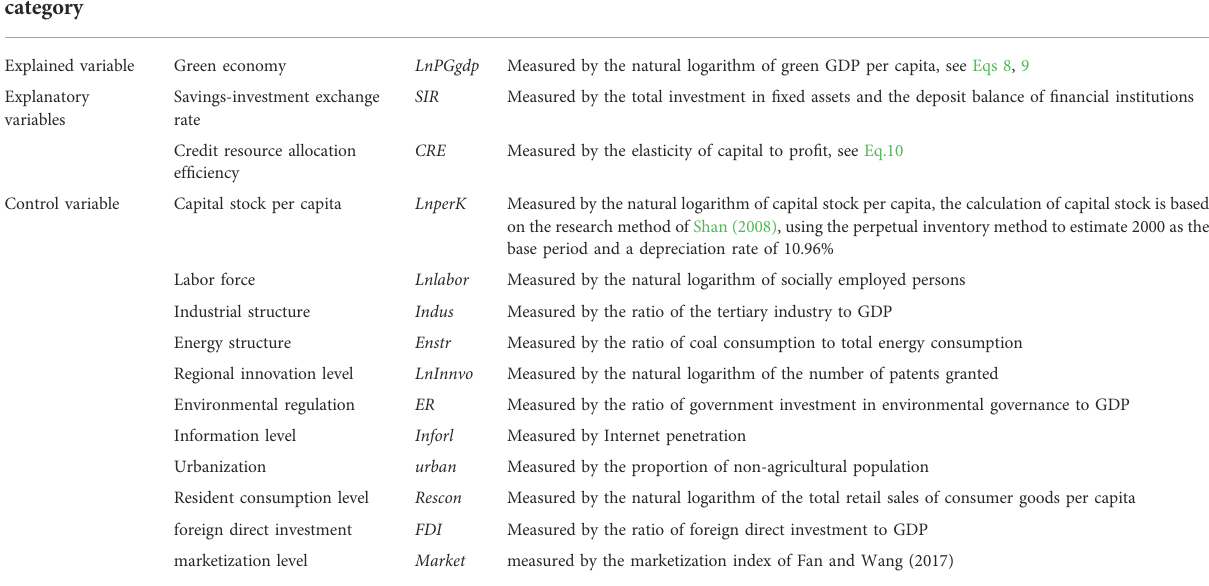
TABLE 1 Variable